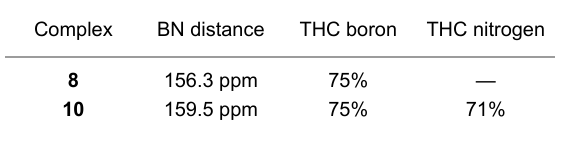
Table 2: Bond length and tetrahedral character (THC) of boronates 8 and 10 .